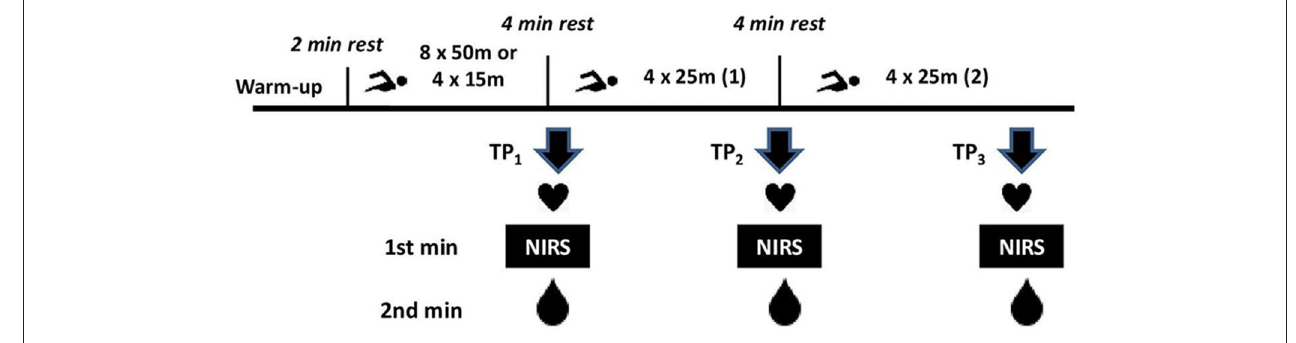
FIGURE 1 | Schematic representations of the testing procedure. TP 1 = testing point 1; TP 2 = testing point 2; TP 3 testing point 3.